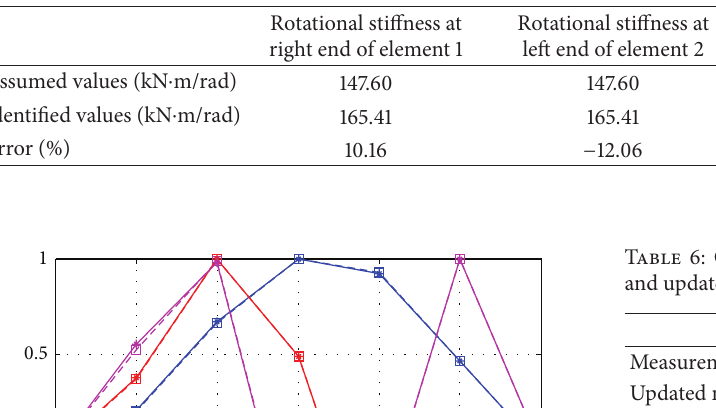
Figure 3: Single damaged structure and model. Table 5: Assumed and identified rotational stiffness for multiple damage case.